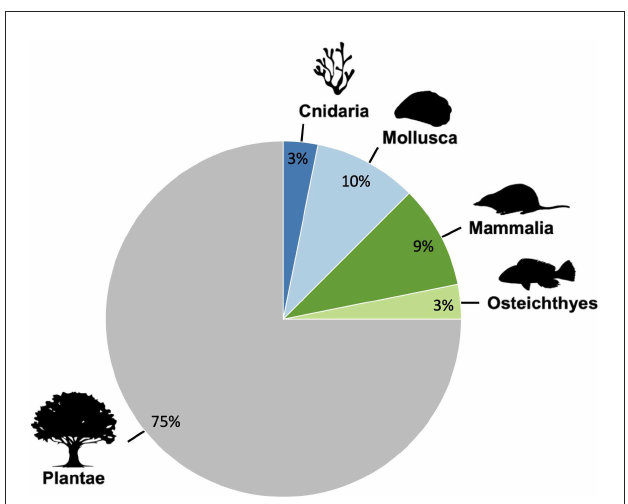
FIGURE3 Proportion of action studies ( n = 48) that focus on invertebrates (Cnidaria and Mollusca), vertebrates (Mammalia and Osteichthyes), and Plantae. Silhouettes were retrieved and modified from Canva (accessed 18 January